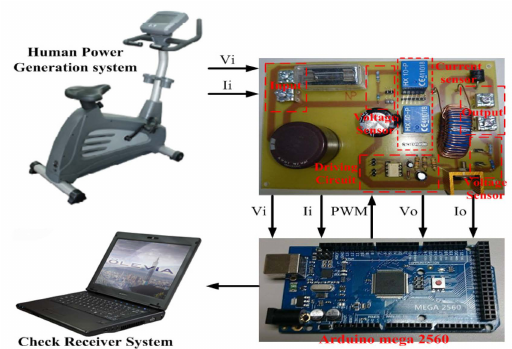
Figure 10. The structural diagram of the actual hardware.